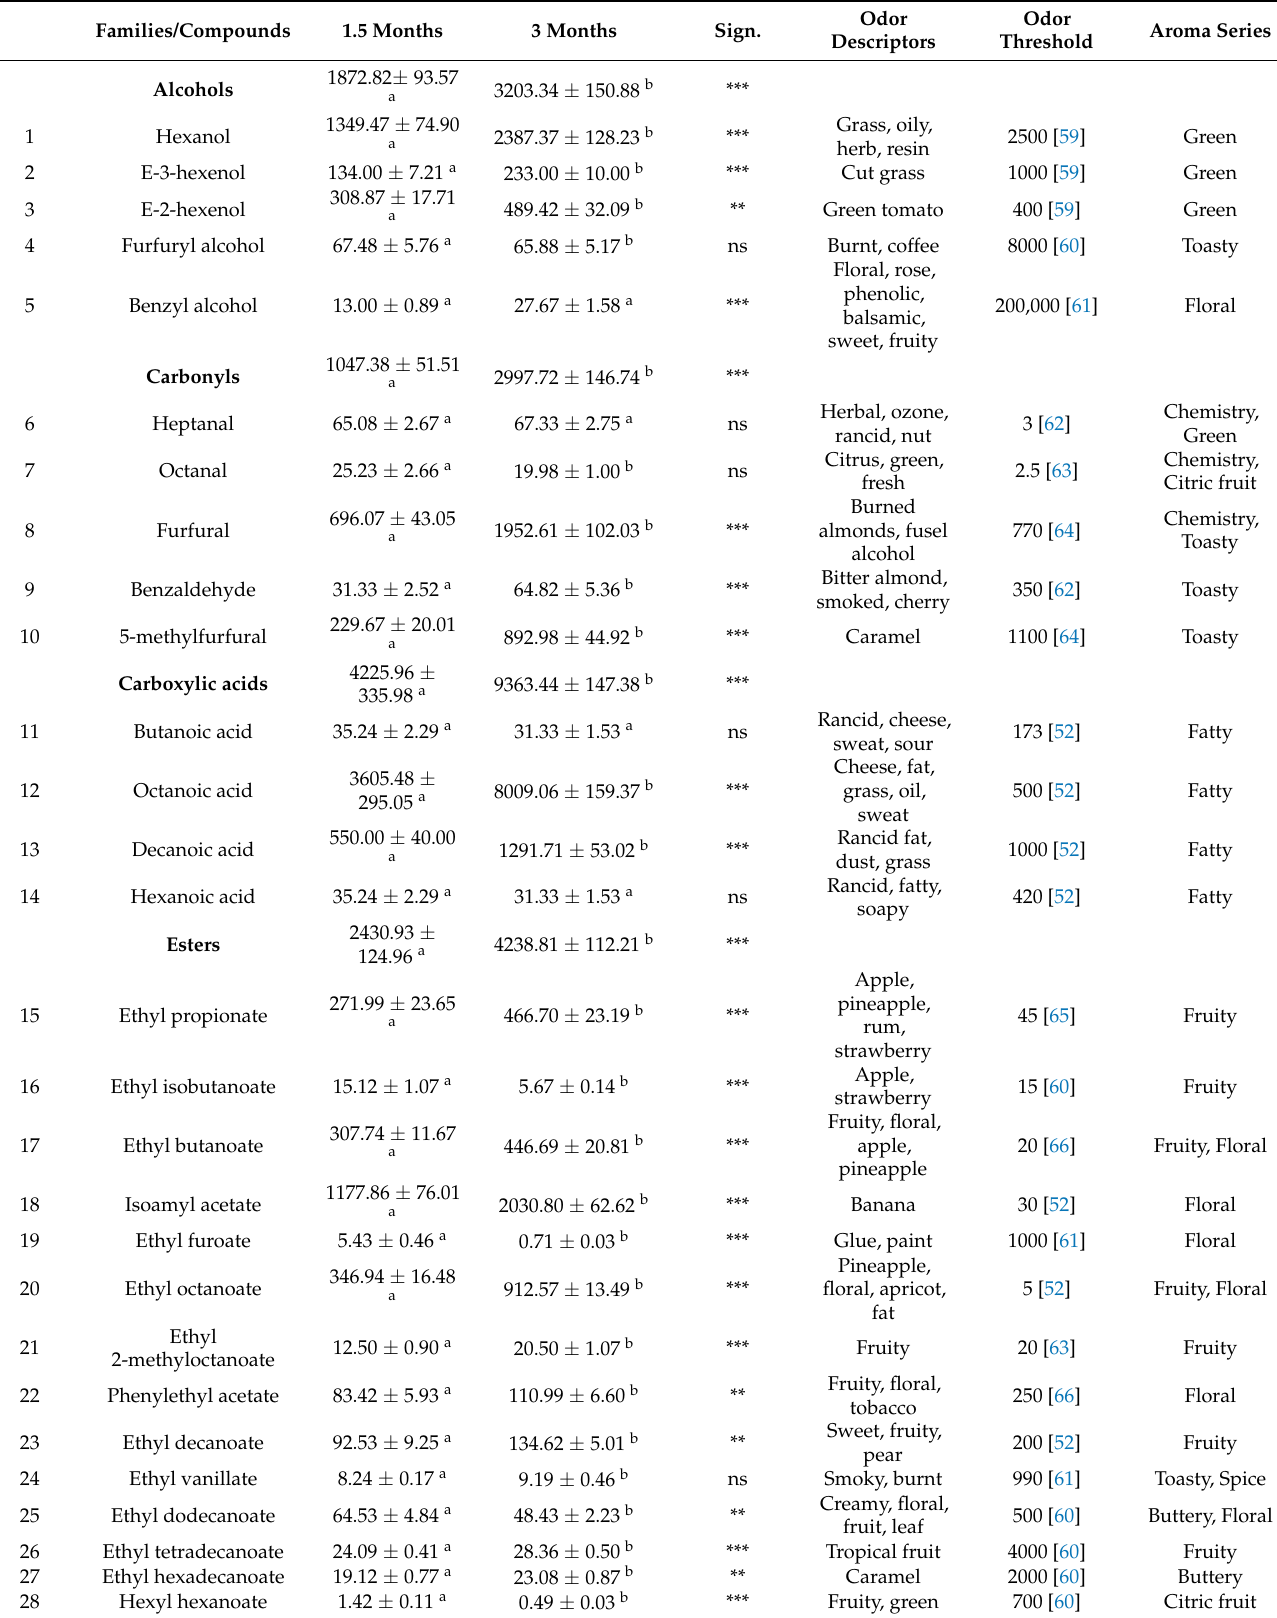
Table 2. Minor volatile compounds ( µ g/L) in wines aged with oak staves for 1.5 and 3 months. Variance analysis.